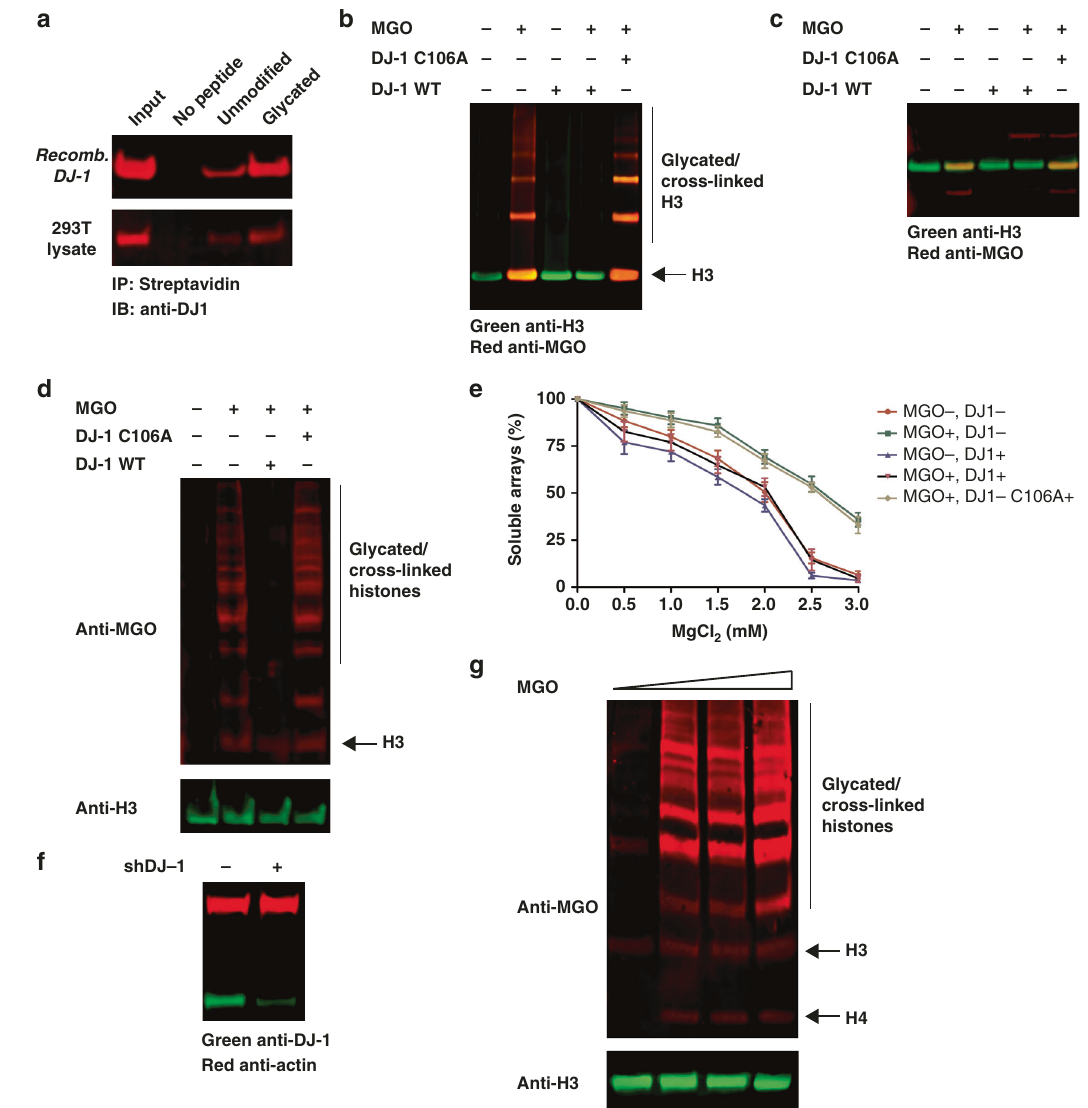
Fig. 5 Histone glycation is repaired by DJ-1 in vitro and in cellulo. a Either non-glycated or glycated biotin-H3 tail (residues 1-18) was incubated with either recombinant DJ-1 or a 293T lysate at 4 °C for 2 h. Subsequently, peptides were enriched by streptavidin bead pull-down and analyzed by anti-DJ-1. b Full- length H3 was either treated or not treated with 1 mM of MGO (corresponding to 1:2 sites:MGO stoichiometry) for 2 h at 37 °C after which, either wild- type DJ-1 or catalytically inactive mutant C106A DJ-1 was added for an additional hour. Samples were analyzed on SDS-PAGE with the indicated antibodies. c NCPs were treated with MGO in the presence or absence of either wild-type DJ-1 or catalytically inactive mutant C106A DJ-1. Samples were analyzed by SDS-PAGE followed by a western blot with the indicated antibodies. d 293T cells were either not transfected, or transfected with wild-type or catalytically inactive mutant C106A DJ-1, and then grown in the absence or presence of 0.5 mM MGO for 12 h after which histones were extracted in a high salt buffer and analyzed by western blot with the indicated antibodies. e Mg 2 + compaction experiments of nucleosomal arrays treated with MGO in the presence or absence of wild-type DJ-1. Error bars represent the standard deviation from three different experiments. f shRNA of DJ-1. 293T cells were transfected with shRNA plasmid and 24 h later were harvested. Total cell lysate was analyzed by western blot with anti-DJ-1 and anti-Actin as a loading control. g 293T cells transfected with shRNA DJ-1 were incubated with 0, 0.25, 0.5 and 1 mM of MGO for 12 h at 37 °C, after which histones were extracted with high salt and analyzed by western blot with the indicated